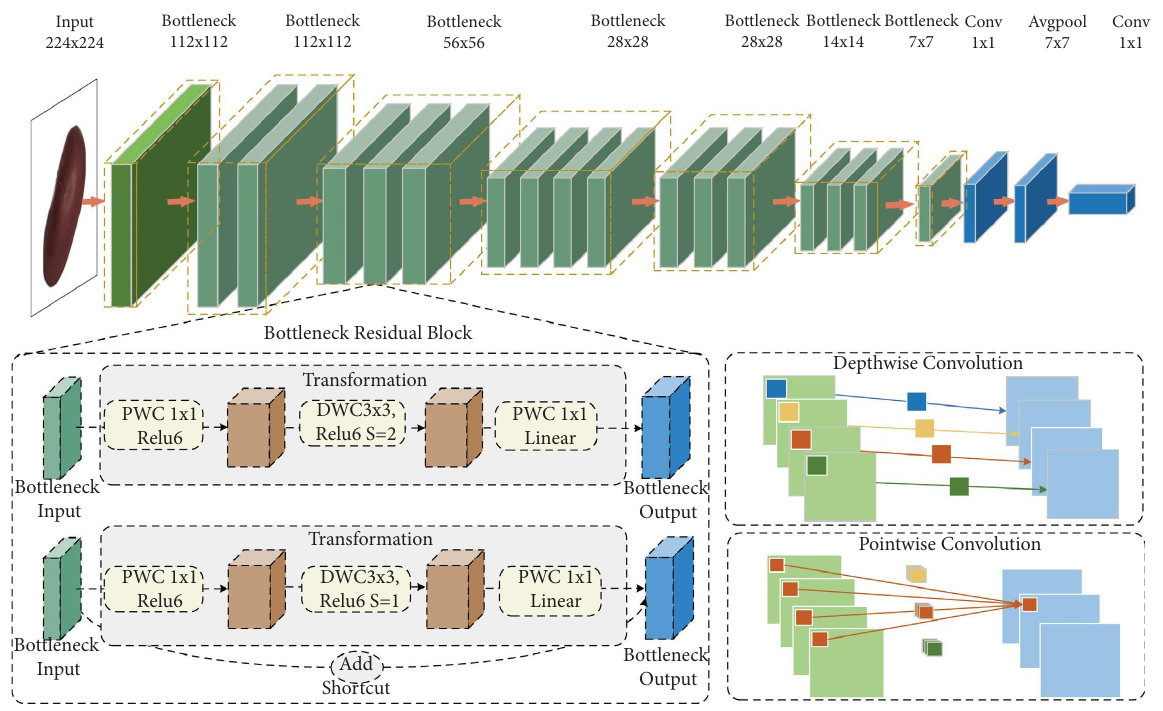
Figure 1: Structure of the MobileNetV2 model for seed sorting. Table 2: Architecture of